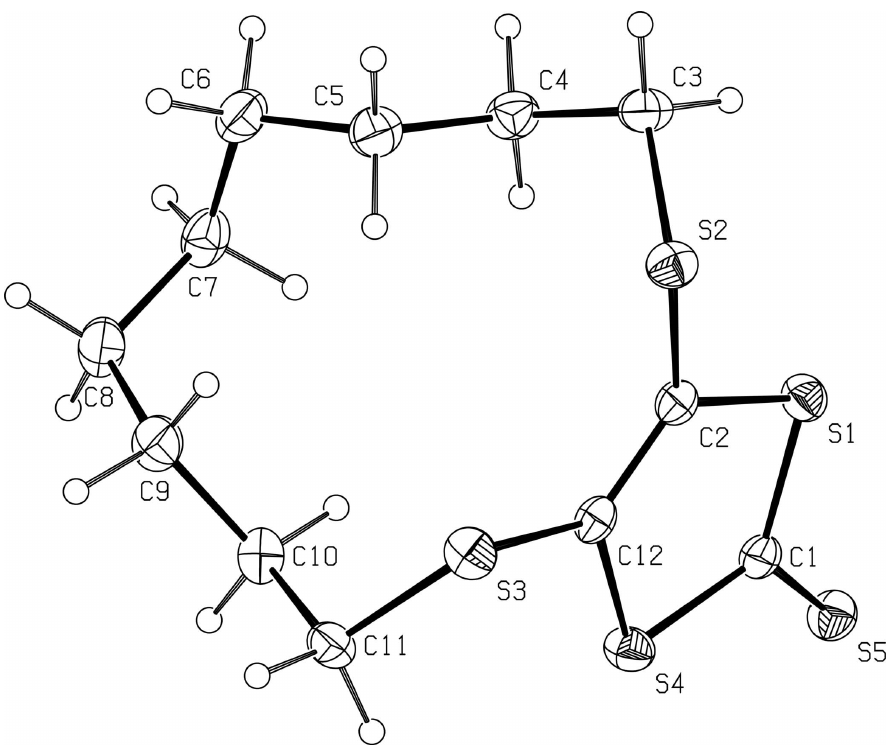
The molecular structure of the title molecule, with the atom-numbering scheme. Displacement ellipsoids are drawn at the 30% probability